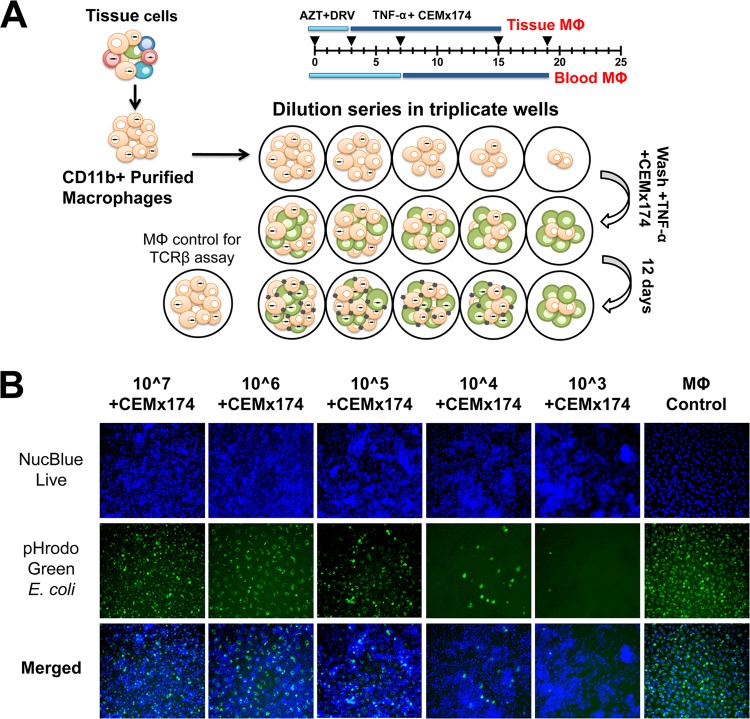
Mϕ-QVOA. Monocytes from blood and tissue macrophages from BAL fluid, lung, spleen, and brain were collected from SIV-infected animals and purified by CD11b-specific bead selection. Macrophages expressing CD11b were plated in serial dilutions in triplicate wells. Cells were cultured with zidovudine (AZT) and darunavir (DRV). Nonadherent cells and the antiretrovirals were removed prior to activation with TNF-α and coculture with CEMx174 cells. (A) Schematic of Mϕ-QVOA. (B) Live fluorescence microscopy of CD11b+ monocyte-derived macrophages cocultured with CEMx174 cells stained with NucBlue live nuclear marker (top row, blue) or pHrodo Green E. coli (middle row, green). Merged images are shown in the bottom row. Images were taken on a Nikon Eclipse TE200 microscope. Magnifications, ×10.